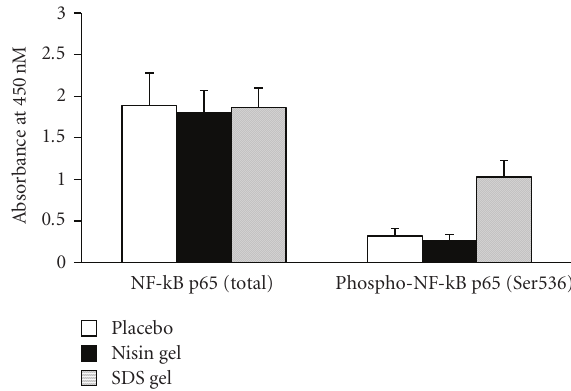
Figure 8: Levels of cytokines (IL-4, IL-6, IL-10 and TNF- α ) in CVL after intravaginal application of nisin (15.15mM in 2mL of 1% polycarbophil gel) SDS (56 μ M in 2mL of 1% polycarbophil gel) and 2mL of 1% polycarbophil gel for 14 consecutive days. CVL are collected on day 15, separated from cell debris by centrifugation and used for cytokine determination as per the protocol given in the material and methods section. Each value is the mean ± SD of six observations from three separate experiments. No significant di ff erence in cytokine levels was observed between placebo and nisin gel treated groups. In contrast the levels were significantly increased in SDS gel treated animals ( ∗ = values are statistically significant at P < 0 . 05).